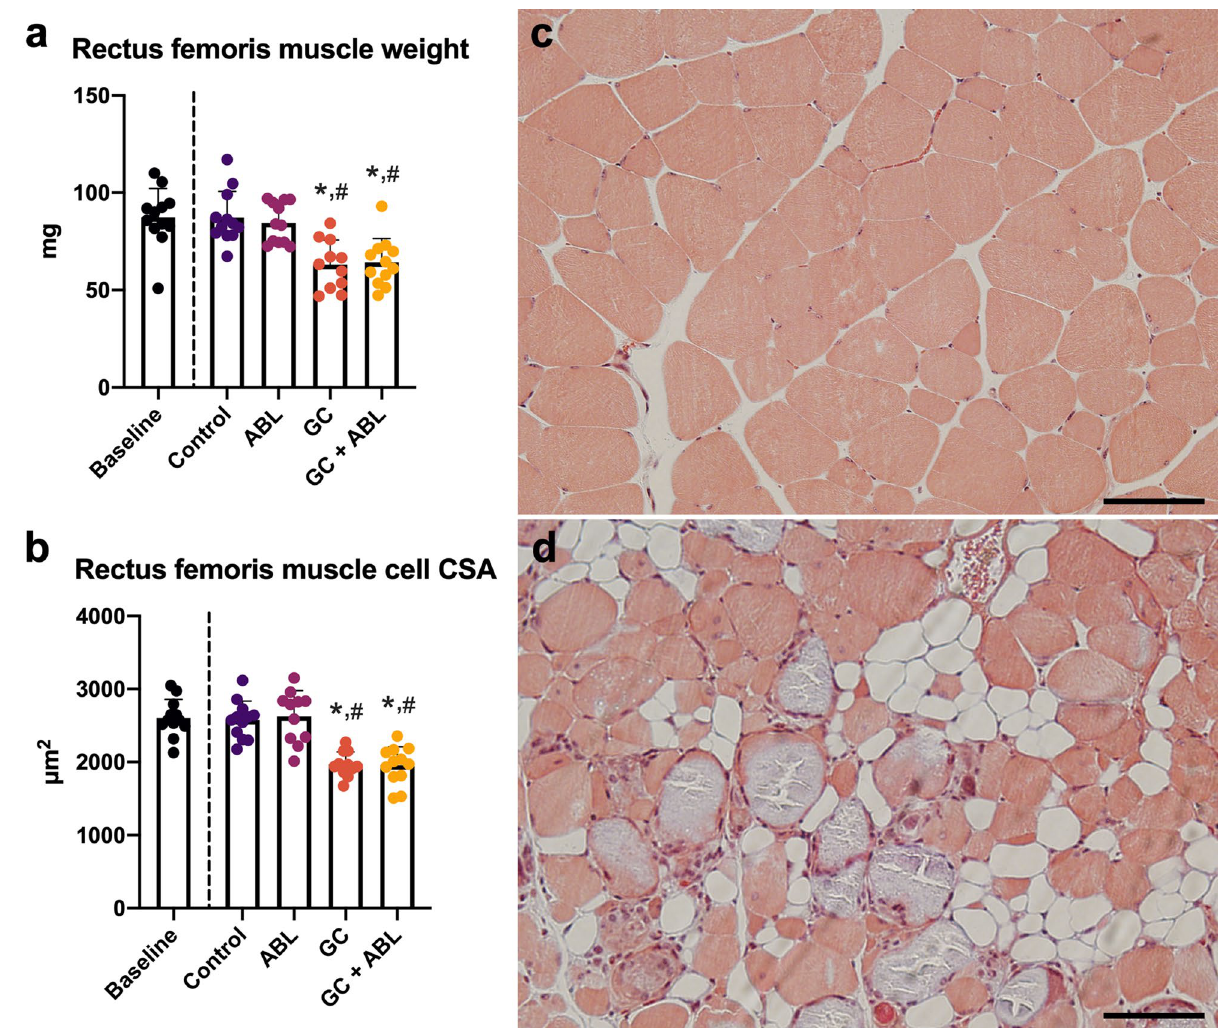
Figure 3. ( a ) Rectus femoris muscle mass and ( b ) rectus femoris cross-sectional area (CSA) of mice subjected to subcutaneous slow-release glucocorticoid (GC) pellets and treated with abaloparatide (ABL) for four weeks. ( c ) Representative cross-section of the rectus femoris muscle cells from a mouse in the Control group. ( d ) Representative cross-section of the rectus femoris muscle from a mouse in the GC group. Bar = 100 µm and stained with Masson trichrome. Mean ± SD. * p < 0.05 vs. Control. # p < 0.05 vs.